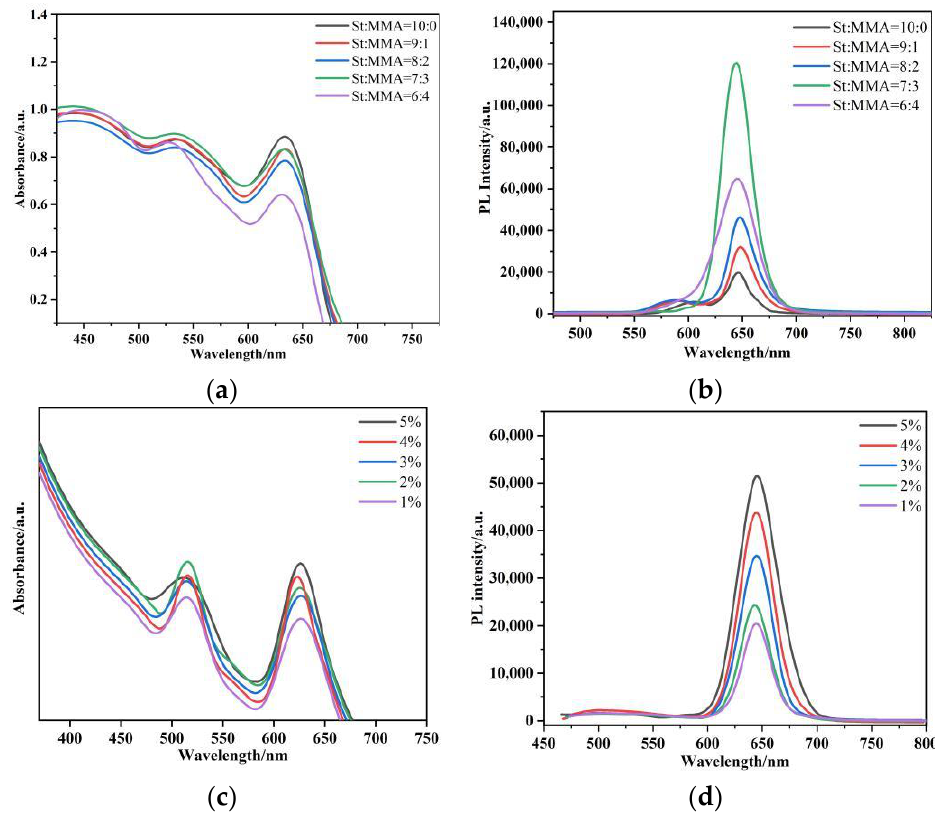
Figure 2. ( a ) Absorption and ( b ) photoluminescence spectra of P(S+MMA) with different volume proportions of packaged CdSe quantum dots. ( c ) Absorption and ( d ) photoluminescence spectra of the CdSe@P(S+MMA) nanofiber network with different CdSe weight content. λ exc = 450 nm. SEM images of the hybrid fibers with different QD contents are shown in Figure